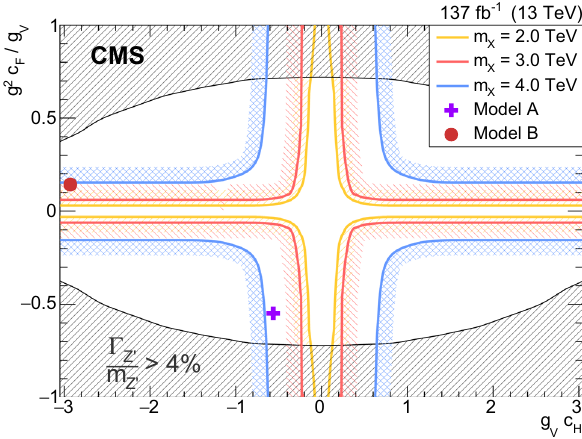
Fig. 8 ObservedexclusionlimitinthespaceoftheHVTmodelparam- eters [ g V c H , g 2 c F / g V ], described in the text, for three different mass hypotheses of 2.0, 3.0, and 4.0TeV for the non-VBF signal. The shaded bands indicate the side of each contour that is excluded. The benchmark scenarios corresponding to HVT models A and B are represented by a purple cross and a red point, respectively. The region of the parameter space where the natural resonance width ( Γ Z (cid:3) ) is larger than the typical experimental resolution of 4%, for which the narrow-width approxima- tion is not valid, is shaded in grey